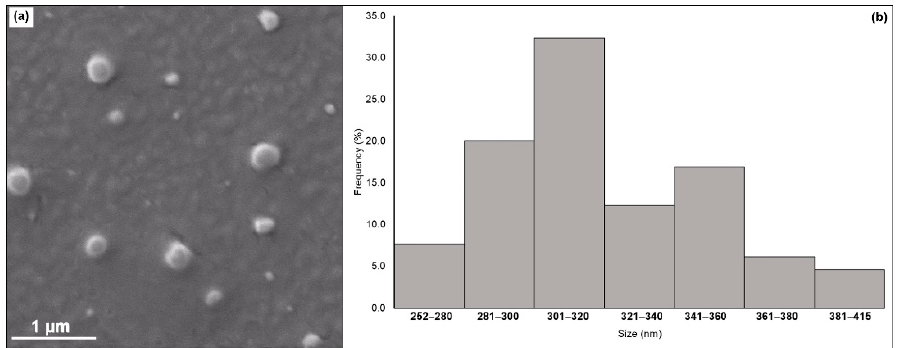
Figure 4. ( a ) SEM micrograph and ( b ) particle size distribution of the CGP-PPG@diclofenac